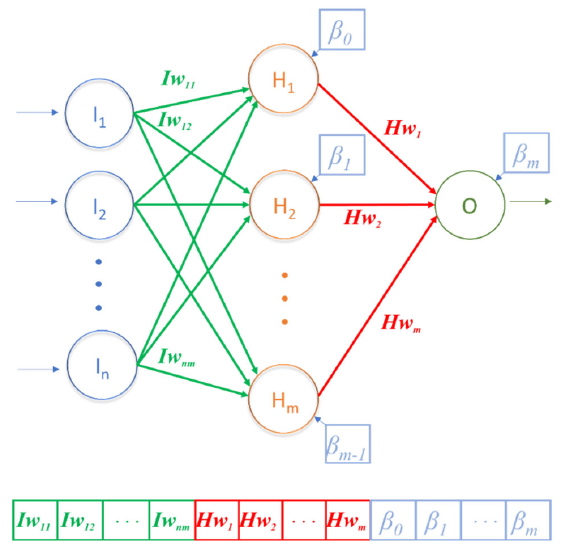
Fig. 4. Representation of the MVOSANN universe for the MLP